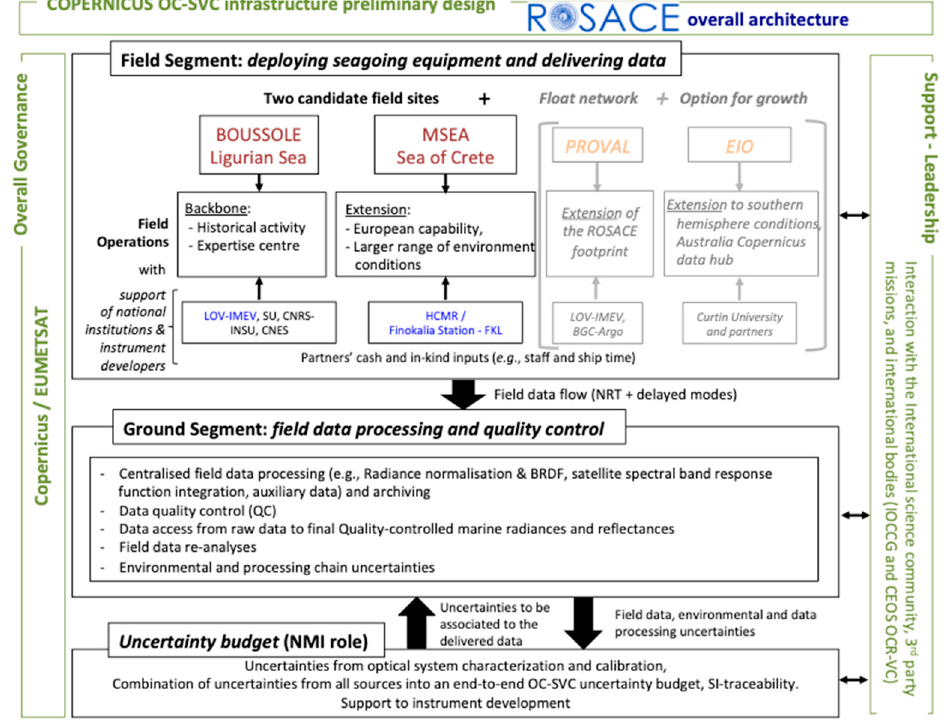
Figure 1. Overall architecture proposed for radiometry for ocean colour satellites calibration and community engagement (ROSACE).